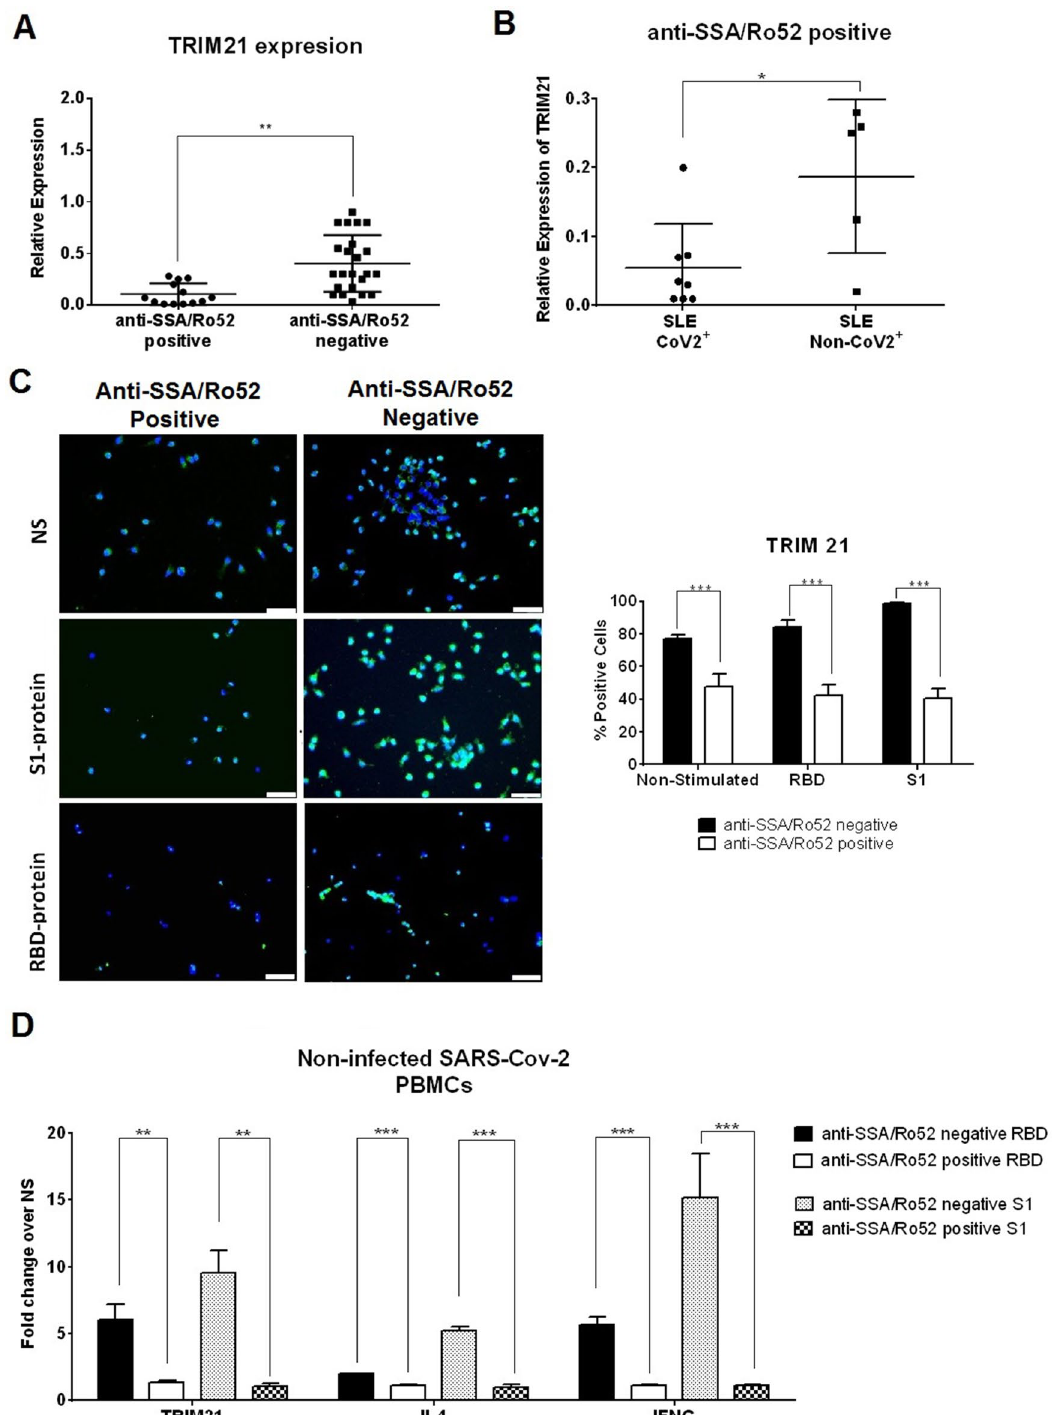
Figure 2. TRIM21 gene expression and protein levels in peripheral blood mononuclear cells (PBMCs) from lupus patients in the presence or absence of anti-SSA/Ro52 antibodies (N = 45). ( A ) TRIM21 expression levels in PBMCs obtained from unexposed lupus patients with anti-SSA/Ro52 (positive, N = 13) and without anti-SSA/Ro52 (negative, N = 32) antibodies. Relative gene expression was calculated using the 2 −ΔΔCt method and GADPH was used as endogenous control. ** p < 0.005. ( B ) Quantitative real-time reverse- transcriptase PCR (RT-qPCR) of TRIM21 in lupus patients with anti-SSA/Ro52 positive antibodies exposed to SARS-CoV-2 (CoV2 +) or unexposed (Non-CoV2 +). * p < 0.05. ( C ) PBMCs from unexposed lupus patients with or without anti-SSA/Ro52 antibodies were stimulated with RBD protein, S1 protein or NS (non-stimulated condition, only PBS stimulation). After 24 h, PBMCs were analyzed by immunofluorescence to measure TRIM21 protein expression levels (green). Blue color (DAPI) labels cell nuclei. Error bars represent the mean ± SEM from three independent experiments. Scale bar = 50 µm. *** p < 0.0001. ( D ) TRIM21, IL4 and INFG gene expression was evaluated in PBMCs from unexposed SARS-CoV-2 lupus patients after RBD or S1 protein stimulation. Patients were subdivided into two groups according to the presence or absence of anti-SSA/Ro52 antibodies. In vitro stimulation was performed using RBD or S1 protein over 24 h. RT-qPCR gene expression analysis was performed thereafter. Fold change in expression level was calculated over non-stimulated conditions (PBS stimulation). ** p < 0.005, *** p < 0.0001. All p -values were obtained using unpaired